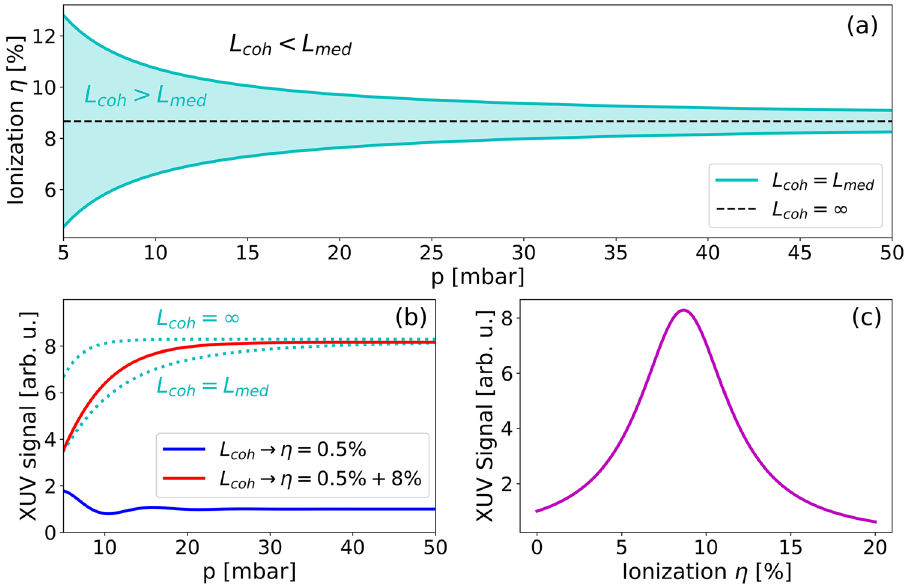
Figure 2. ( a ) Range of optimal ionization degree with L med = 15 mm for 17th harmonic order generated by a 800-nm laser in krypton as a function of pressure (cyan channel) with emphasis on ideal ionization corresponding to L coh → +∞ (black dashed line). ( b ) Describes evolution of the 17th harmonic signal based on Eq. (2), where the optimal signal is in the range L coh > L med (cyan dotted curves). Expected signal from the high-intensity laser in region II as shown in Fig. 1b is denoted by blue curve. By adding a constant pre- ionization of 8% to the same high-intensity laser, the expected signal moves into desired region (red curve). ( c ) The absorption-limited XUV signal as a function of the ionization degree η according to Eq.